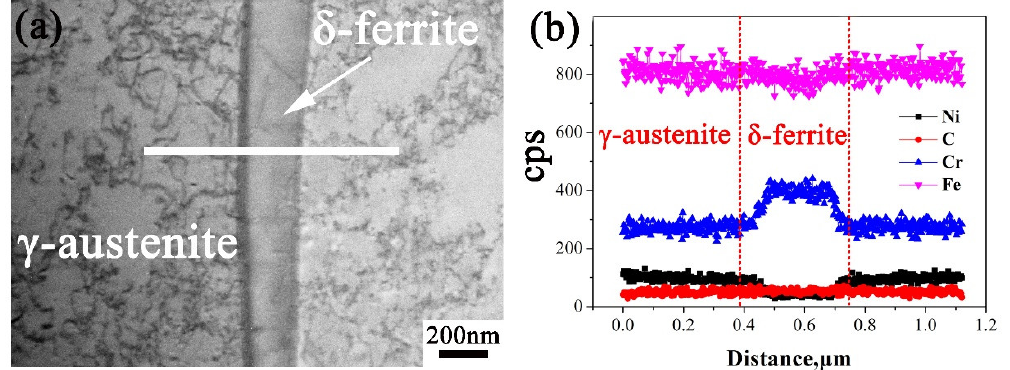
Figure 6. ( a ) TEM morphology and ( b ) EDS analysis across ferrite and austenite.